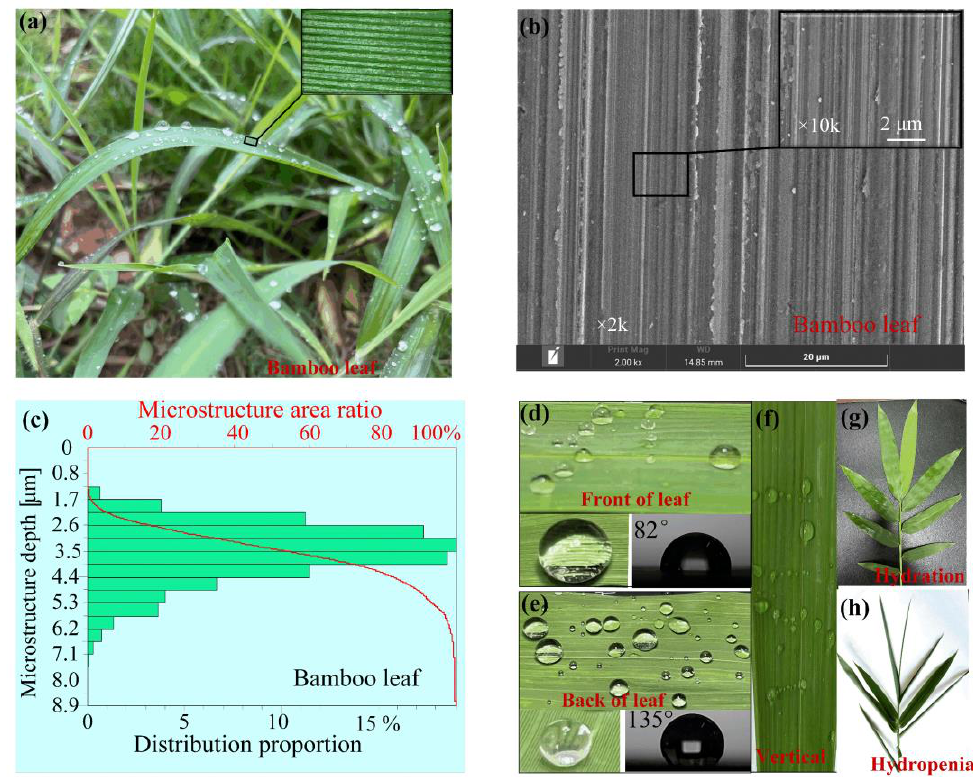
Figure 1. Structural characteristics of bamboo leaf for droplet steering. ( a ) The morphologies of natural bamboo leaf; ( b ) the SEM photo of the fresh bamboo leaf using an environmental scanning electron microscope; ( c ) the Abbott–Firestone curve of the morphology; ( d , e ) are photos of bamboo leaf in the hydration and hydropenia states, respectively; ( f ) droplets pinned on the vertically placed leaf; ( g ) and ( h ) are wetting states on the front side and back side of the leaf,